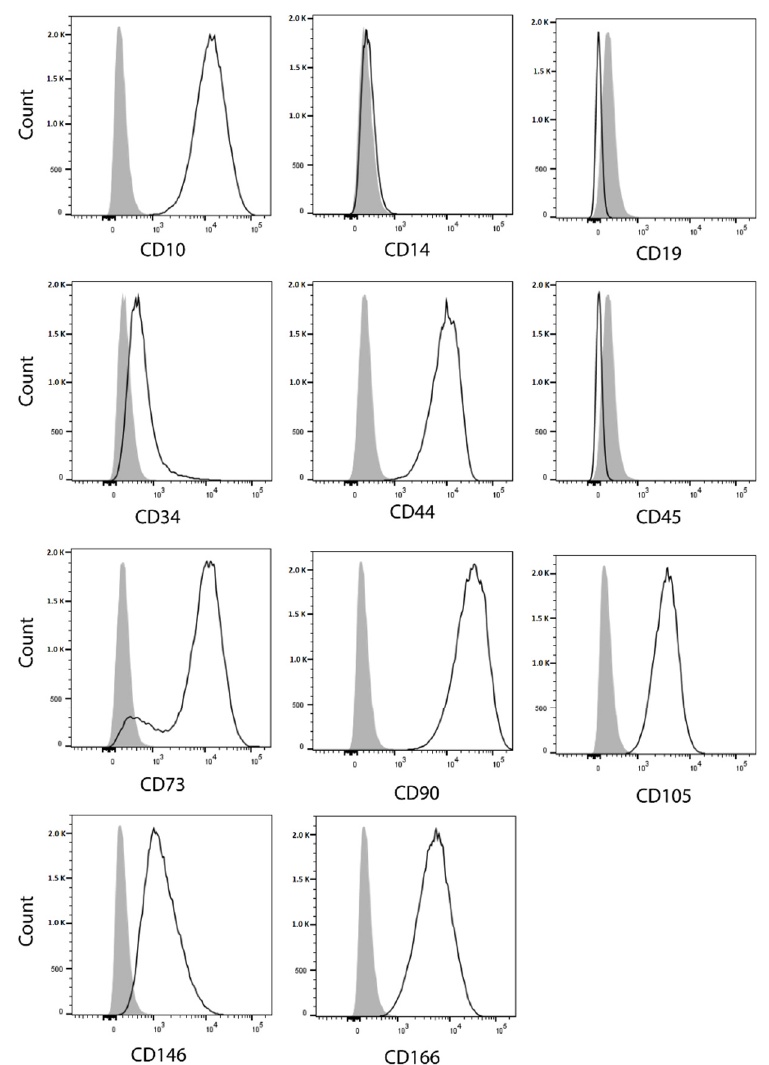
Figure 7. Expression of mesenchymal and hematopoietic lineage markers. Flow cytometry analysis was performed forthe cell surface markers CD10, CD14, CD19, CD34, CD44, CD45, CD73, CD90, CD105, CD146, and CD166.Open histograms (solid lines) represent specific staining profiles for the indicated antigens, whereas shaded histograms show staining with matching isotype control antibodies. Some SRH cells were positive for CD34 (18.6%). Yet, the median fluorescence intensity (MFI) for CD34 was only 2.2, which indicated a rather low antigen